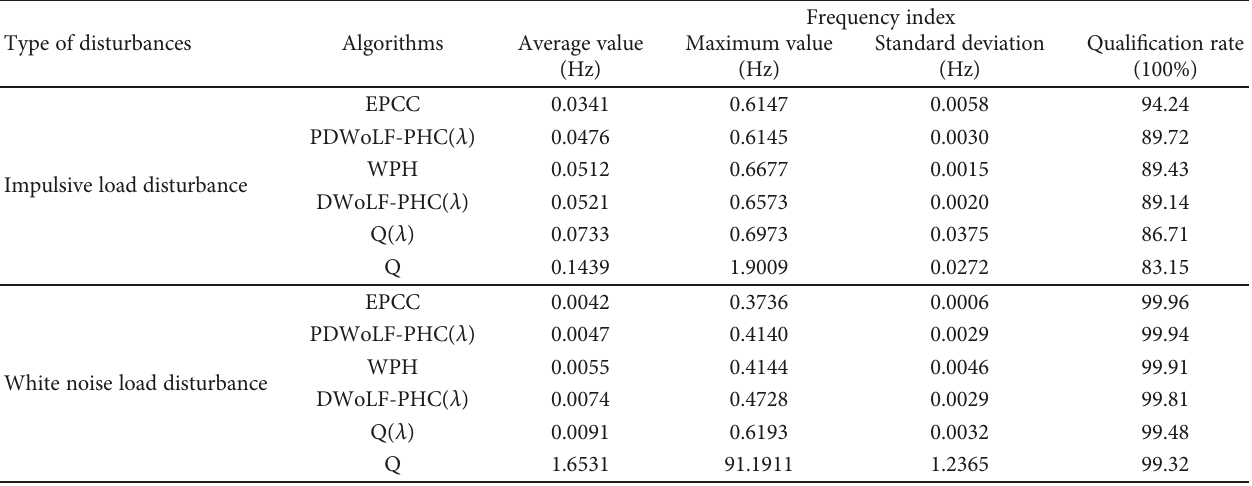
Table 3: Frequency index assessment under impulsive load disturbance and white noise load disturbance. Frequency index Type of disturbances Algorithms Average value